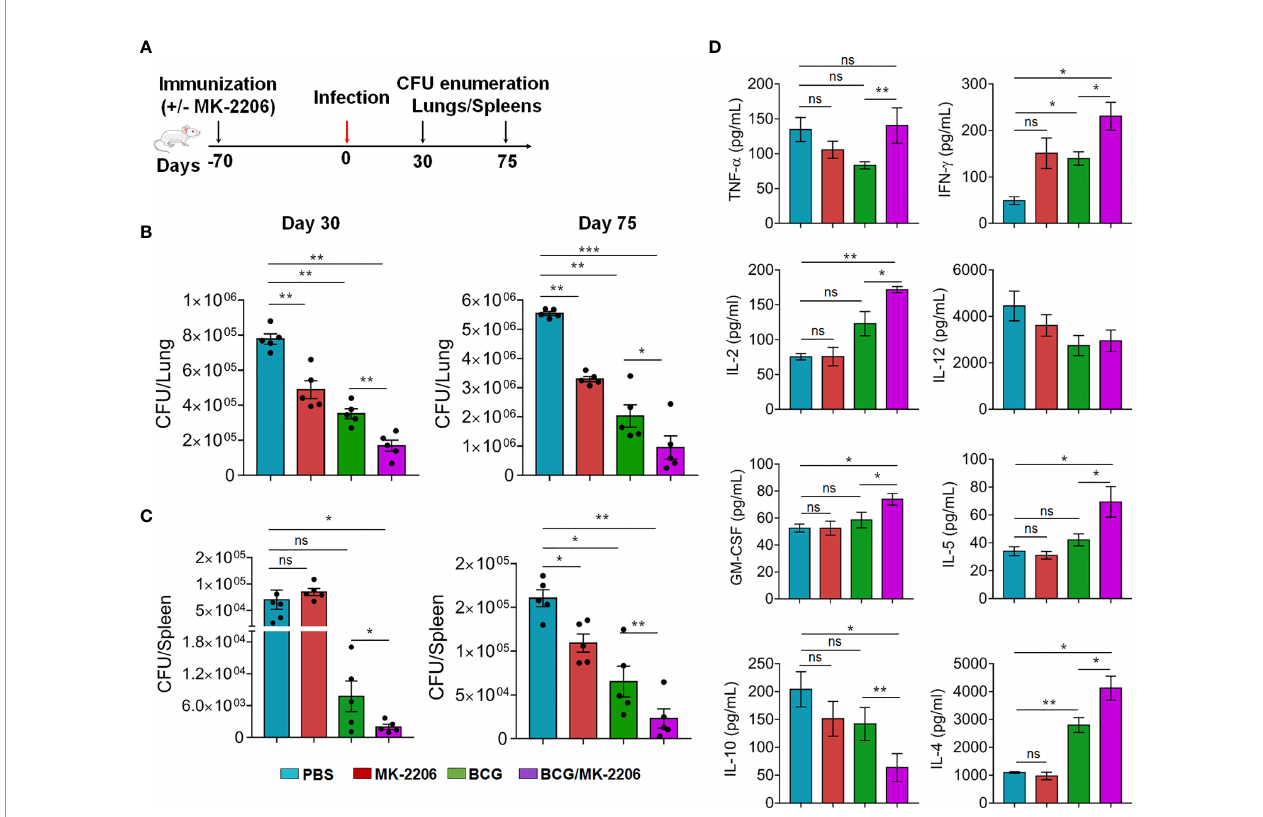
FIGURE 7 | MK-2206 improves BCG elicited protection against TB in mice. (A) Schematic representation of protection study in mice. Animals were primed with BCG vaccine and given two boosts with MK-2206 (25 mg/kg) as described in Materials and Methods . (B, C) . At 70 days post-immunization, animals were infected via aerosol route with a high dose of 300 CFU of Mtb H37Rv. The lungs (B) and splenic (C) bacillary loads were determined at day 30 and day 75 post-challenge. For bacterial enumeration, homogenates were diluted 10.0-fold and 100 m l was plated on 7H11 agar at 37°C for 3 to 4 weeks. The data shown in these panels is representative of two experiments and is mean ± SEM CFU obtained from fi ve to six animals per group per time point. (D) The levels of cytokines were measured in fi ltered lung homogenates by Luminex assay. The data shown in this panel is means ± SEM obtained from n = 5 – 6 mice per group. Statistical differences were obtained for the indicated groups. *p < 0.05; **p < 0.01; ***p < 0.001; ns, non-signi fi